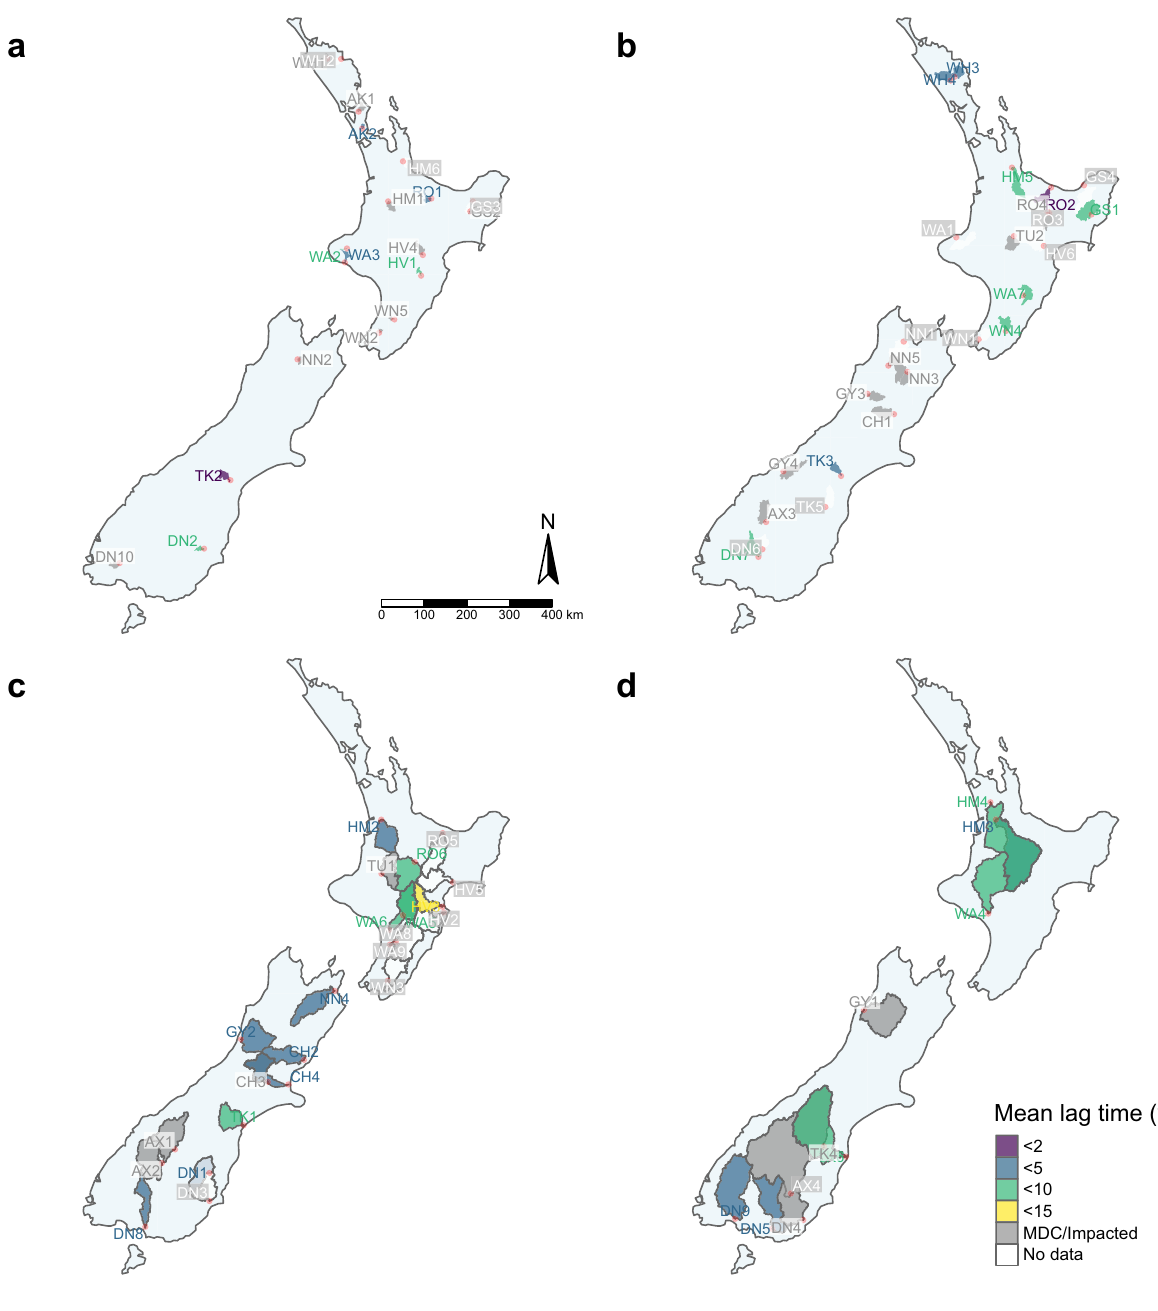
Figure 3. Map of New Zealand showing the location, catchment size and estimated lag time between nitrate–N leaching losses and nitrate–N load for catchments of: ( a ) < 450, ( b ) 451–1800, ( c ) 1801–5000, and ( d ) > 5000 km 2 . Red dots refer to the location of the sampling site. Note that some sites are subsumed within larger catchments of the same lag time class. Maps were created using R (ver. 4.0.3) packages ’sf’ 86 and ’tmap’ 87 ; New Zealand boundary data sourced from https:// www. stats. govt. nz/ while catchment boundaries were sourced from the River Environment Classification database (https:// niwa. co. nz/ fresh water- and- estua ries/ manag ement- tools/ river- envir onment- class ifica